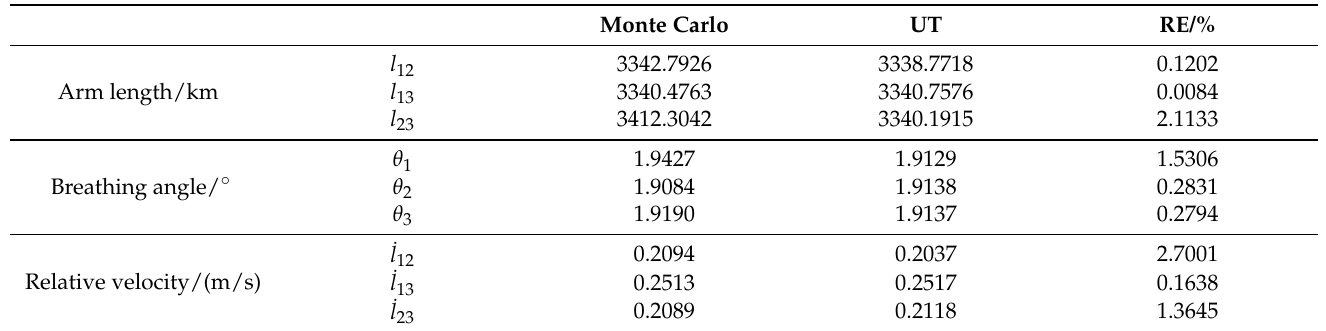
Table 5. STD comparison of the UT ( κ = 9) and the Monte Carlo simulation.